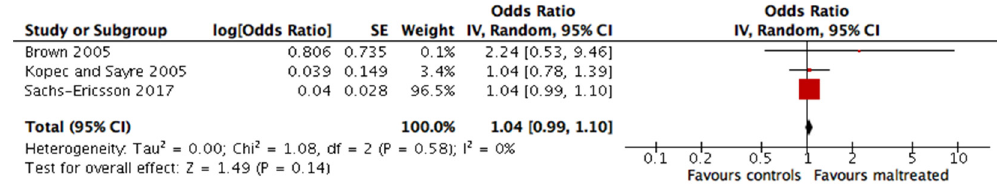
Figure 1. Forest plot illustrating the results of a meta-analysis (random-effects) of prospective, longitudinal studies examining the relationship between childhood physical maltreatment and pain at follow-up, after adjusting for potential confounding variables.